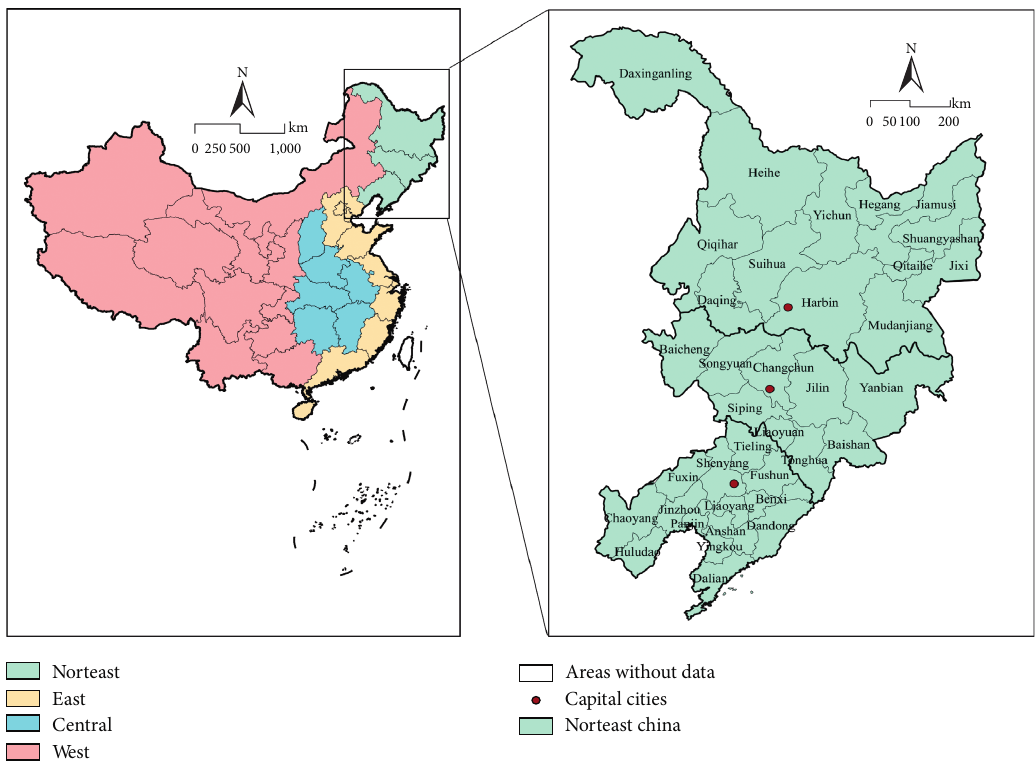
Figure 1: Map of the study